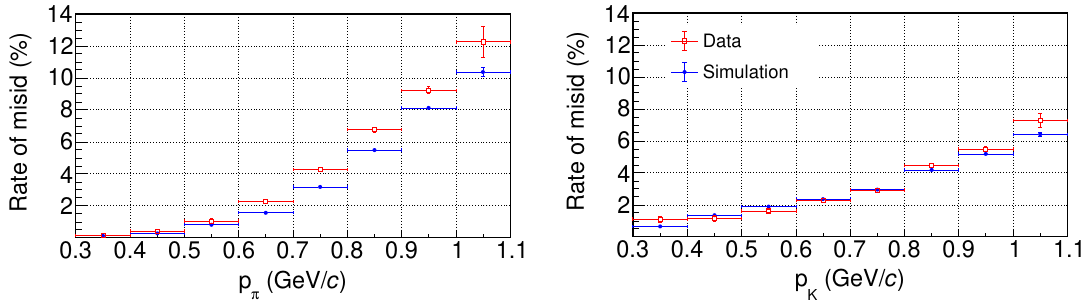
Figure 5 . Probability of π → K (left) and K → π (right) misidentification in bins of momentum, as measured in data and Monte Carlo simulation.